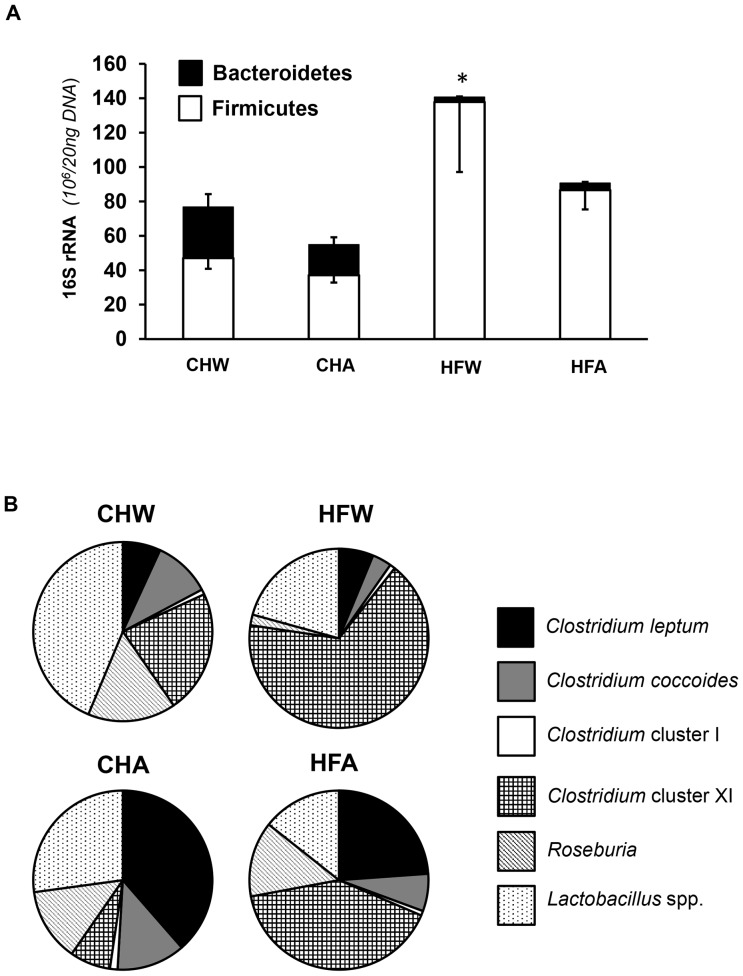
Gut microbiota analyses of diet and fluid treatments.
A. Graphical representation of the absolute changes in the Firmicutes:Bacteroidetes ratio in fresh fecal matter resulting from dietary (chow or high fat) or fluid (water or aspartame) treatment. HFW has elevated levels in comparison to the other groups, with the data representing absolute number (106) of 16S rRNA gene copies per 20 ng DNA. The numerical value above each bar represents the Firmicutes:Bacteroidetes value. B. Relative bacterial abundance within the Firmicutes phyla. Data is based on 16S rRNA gene copies (106/20 ng DNA), on a relative (100%) scale. Consistent with the absolute results (
Table 2
), APM treatment within HF (HFA) increased the relative proportion of Clostridium leptum and attenuated high fat- increased in Clostridium cluster XI. Data from the water controls (chow, high fat) were part of a shared control group that has been previously published [15]. Permission to reuse the data in this figure was obtained from Elsevier. Abbreviations are as follows: CHW, chow water; CHA, chow aspartame; HFW, high fat water; HFA, high fat aspartame. Data represents means ± SE, n = 9–12 per treatment.